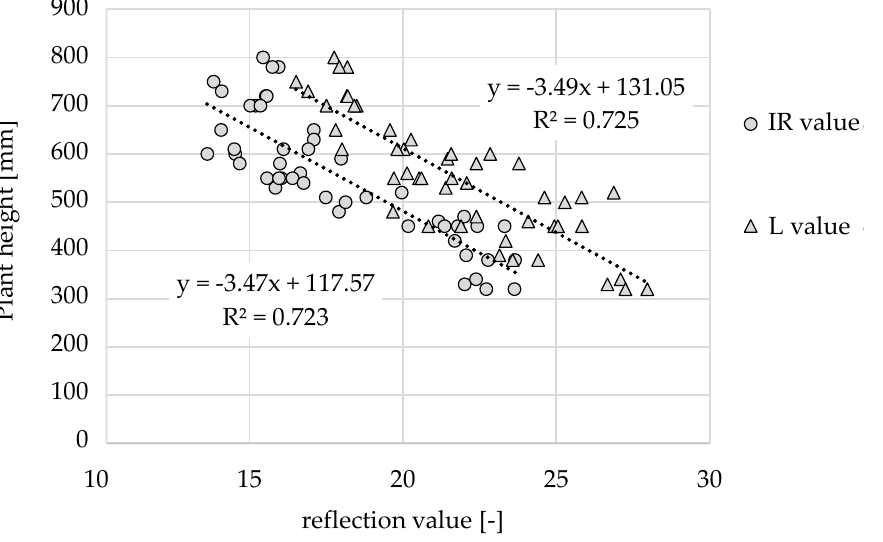
Figure 11. Linear regression model of the plant height with the reflection values of the IR ( p = 2.0753 × 10 − 14 ) and L channel ( p = 1.7399 × 10 − 14 ) over the growth stages BBCHC 32, 39, and 59.